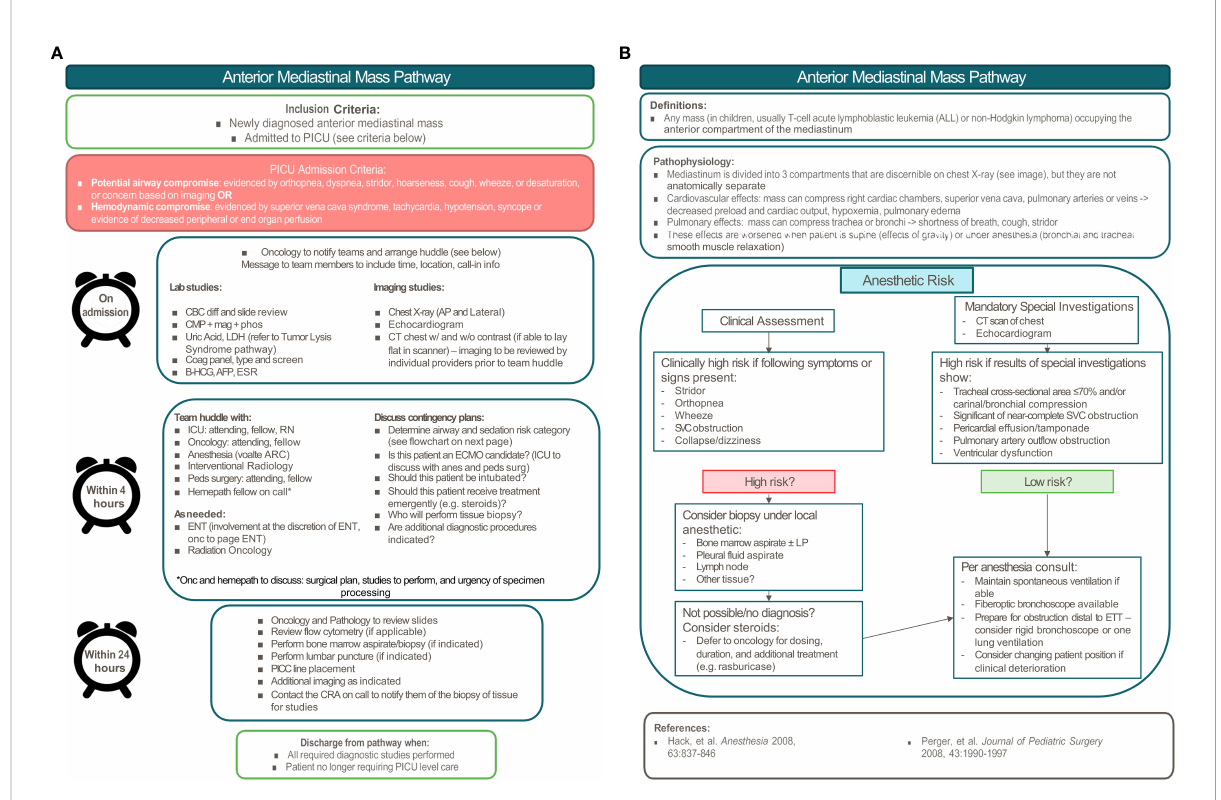
FIGURE 2 Pediatric anterior mediastinal mass pathway. (A) Pathway overview. (B) Anesthetic risk strati fi